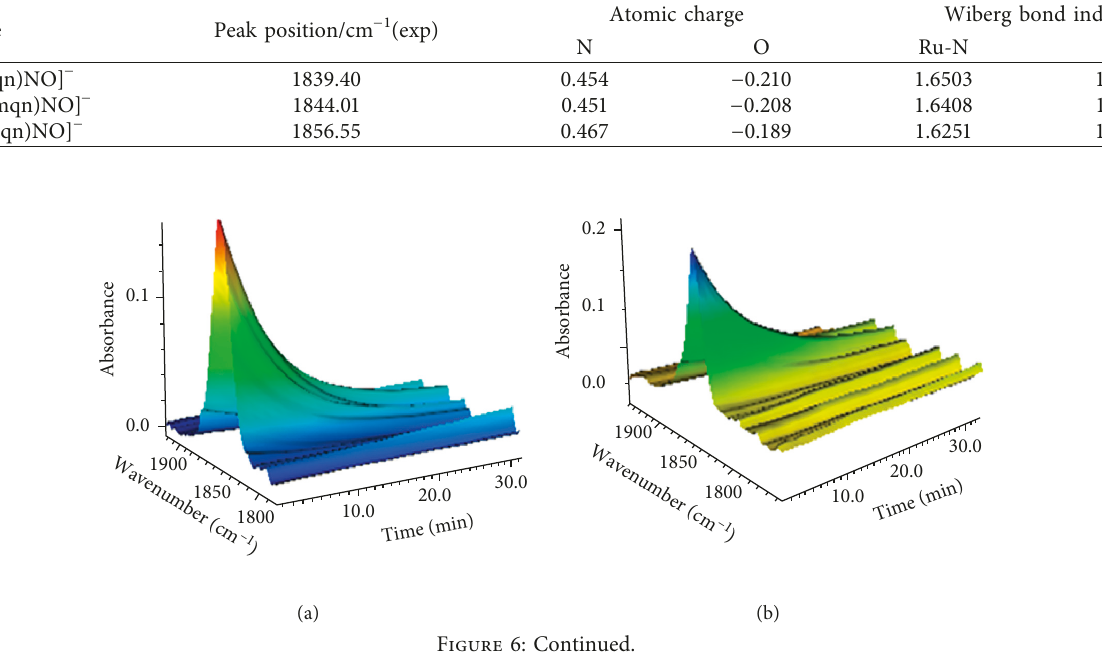
(b), and [RuCl 3 (2cqn)NO] −